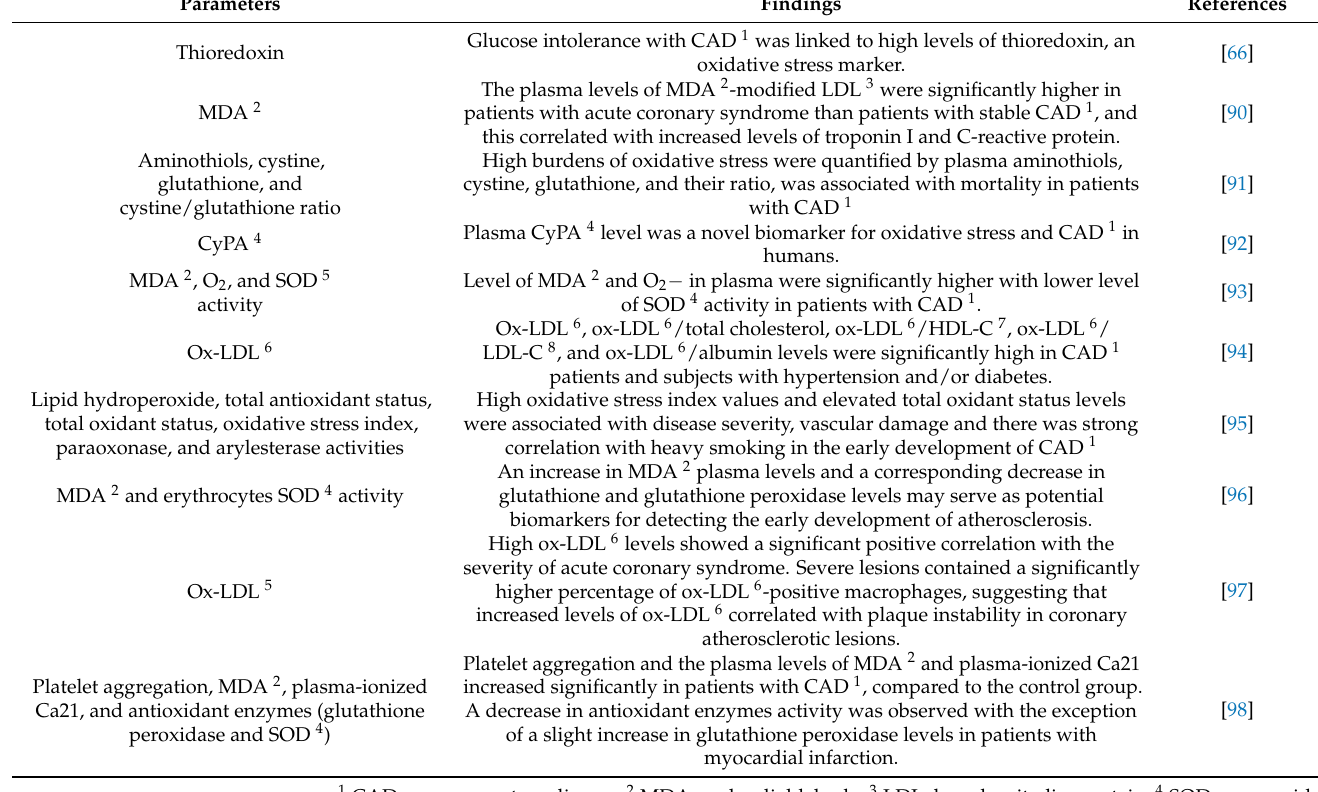
Table 2. Reports on oxidative stress in